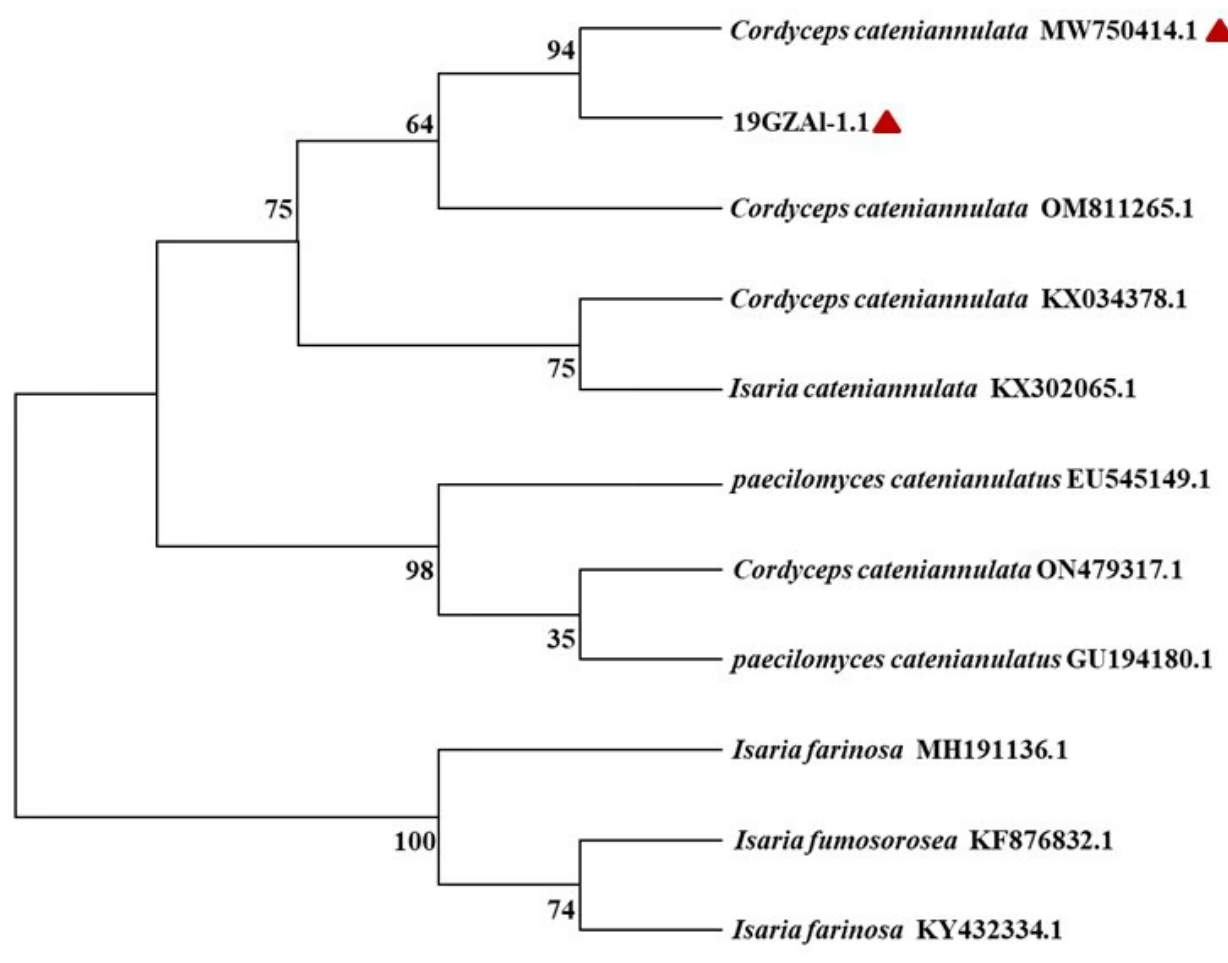
Figure 3. Phylogenetic analysis of the partial rDNA-ITS sequences of the endophytic isolated strain and related species (obtained from GenBank). Note: the two marked with red triangles were originally the same strain. 19GZAl-1.1 was the endophytic strain in this study; MW750414: the accession number of 19GZAl-1 Isaria cateniannula in GenBank submitted by the authors.